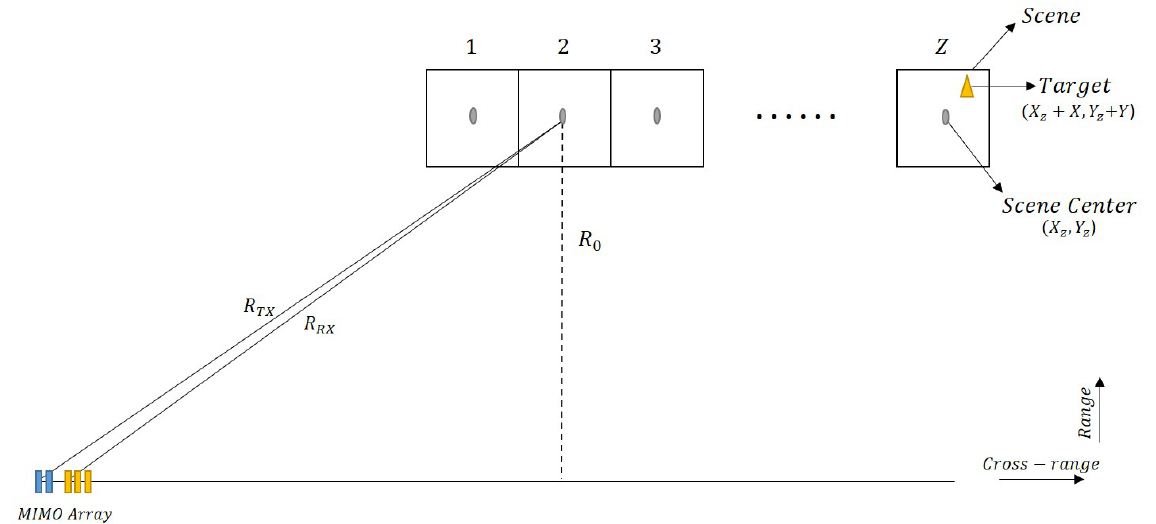
Figure 2. Illustration of Strip-Spot SAR geometric model.